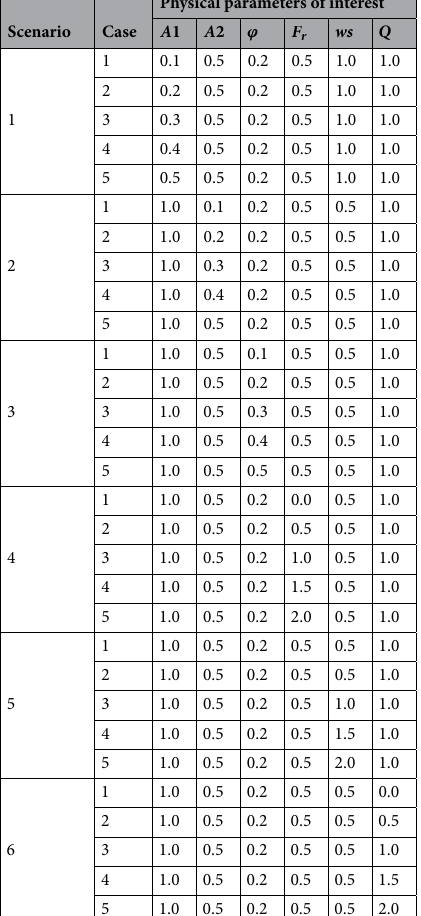
Table 2. Case settings and scenario analysis for the hybrid Nano fluid flow